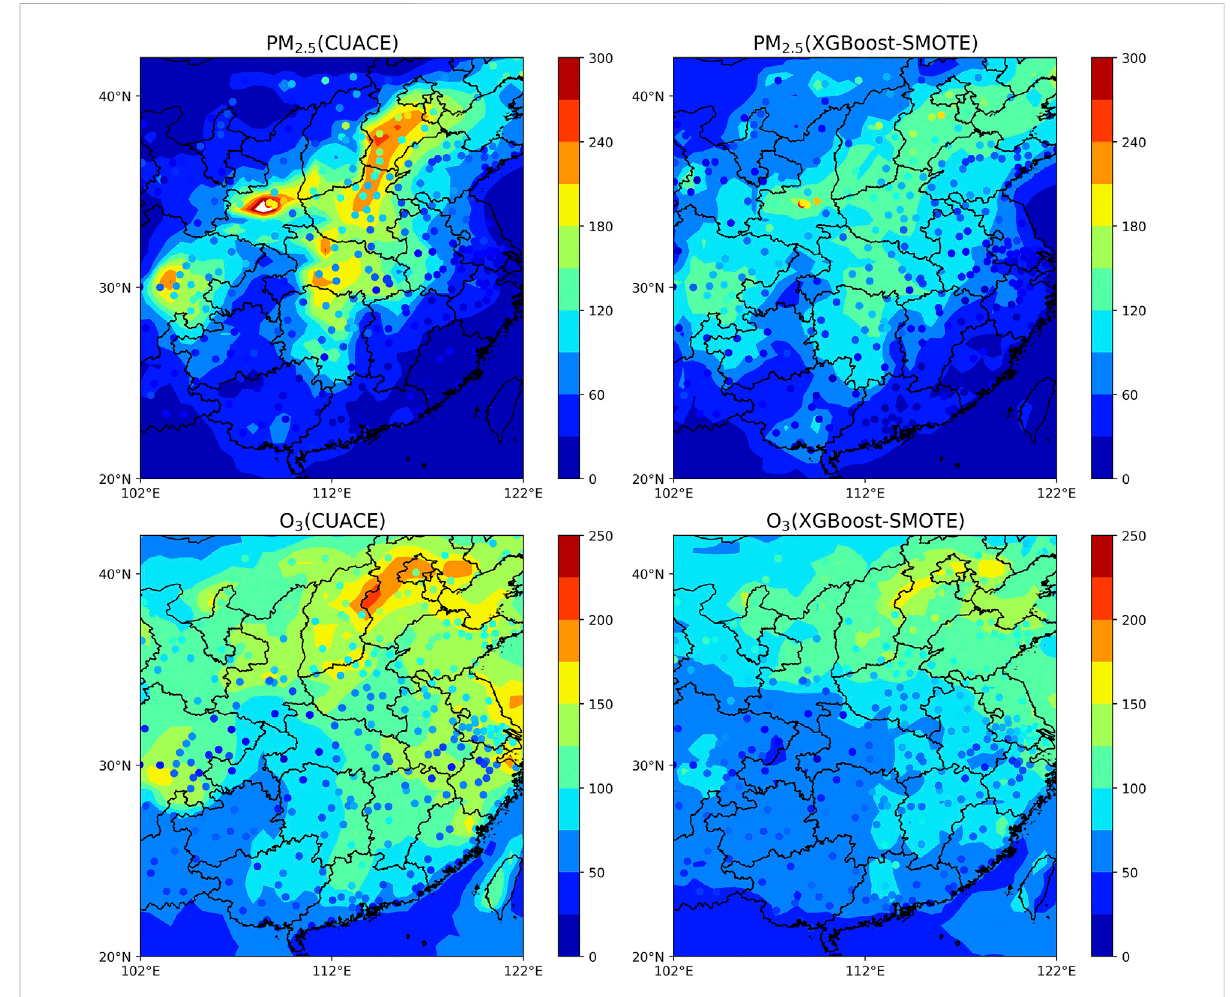
FIGURE 8 PM 2.5 and O 3 observed (spot), CAUCE forecasted and XGBoost-SMOTE optimized concentration spatial distribution